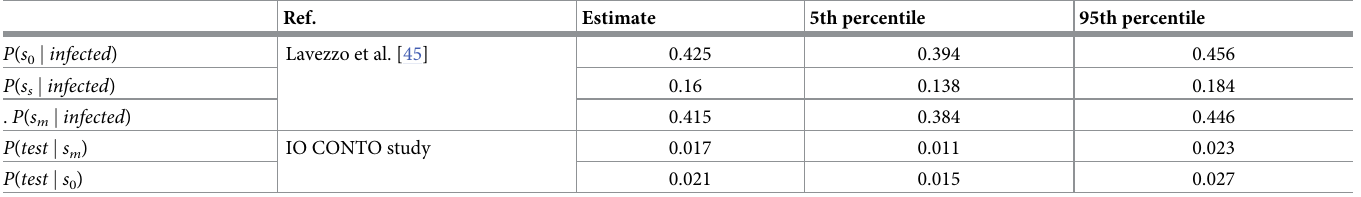
Table 2. Estimated proportion and 5th and 95th percentiles of the Dirichlet/Beta distributions with parameters obtained via the method of moments.